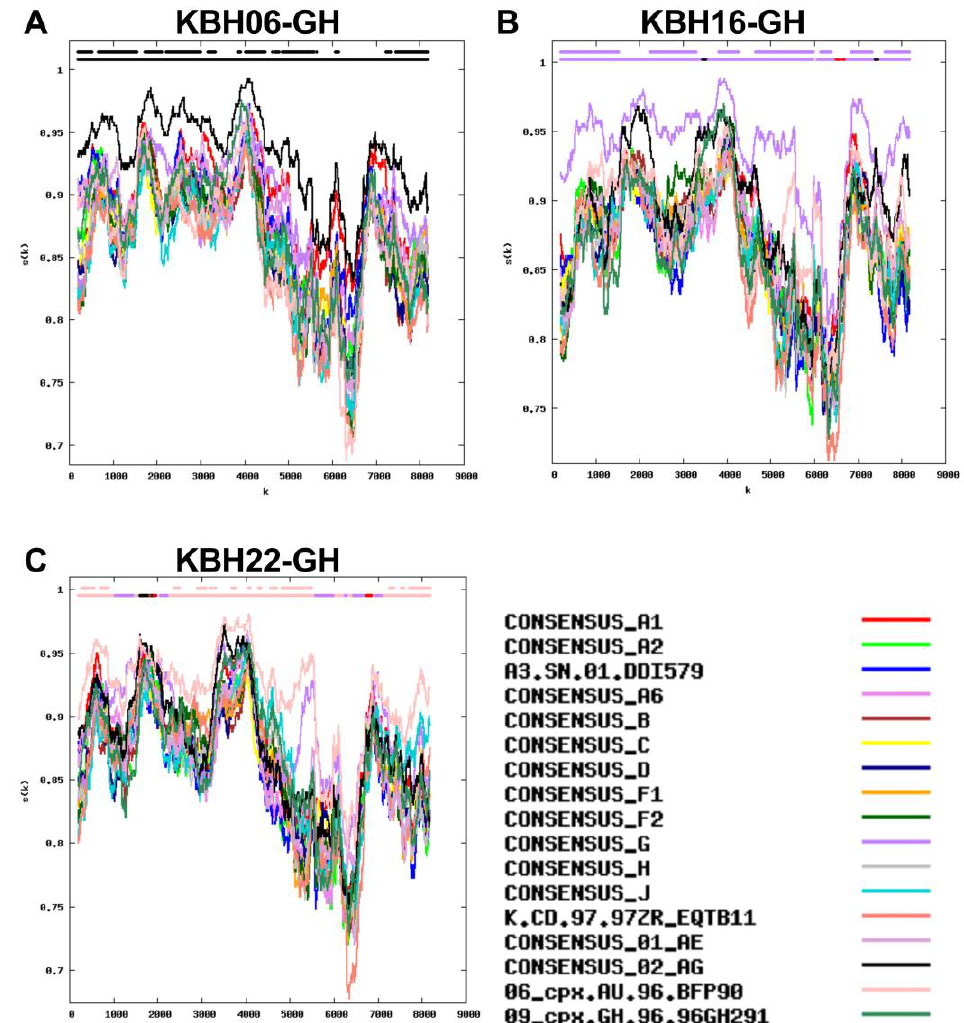
Figure 6. Representative full-HIV-genome similarity plots of major subtypes in our cohort. The y-axis denotes the % similarity between the participant sequence to each of 17 reference sequences (each in a different color) over a sliding window of 400 bases (shown on X axis). The bars at the top of each plot indicate the best matching reference sequence over a given sequence region (lower bar) and whether this match meets the 95% confidence threshold (upper bar). Panel ( A ) CRF02_AG in KBH06-GH. Panel ( B ) Pure Subtype G in KBH16-GH. Panel ( C ) 06_cpx in KBH22-GH.